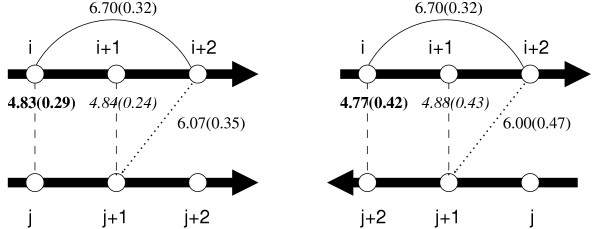
Typical Cα distance in β-sheets. Typical Cα distances computed from the Ref set in parallel (left part) and anti-parallel β-sheets. Mean distances are indicated in Å with their standard deviations within parentheses. Separate statistics were computed for distances involving only residues in strand cores (italic) and distances involving residues at strand edges (bold). For the intra-strand distance (type i to i + 2), no distinction is made on the sheet orientation.